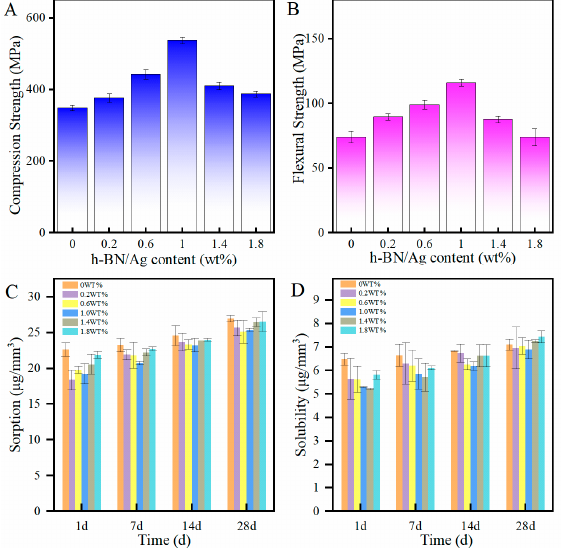
Figure 4. ( A ) Compressive strength of PMMA; ( B ) Bending strength of PMMA; ( C ) Water absorption value of PMMA; ( D ) The dissolution value of PMMA.